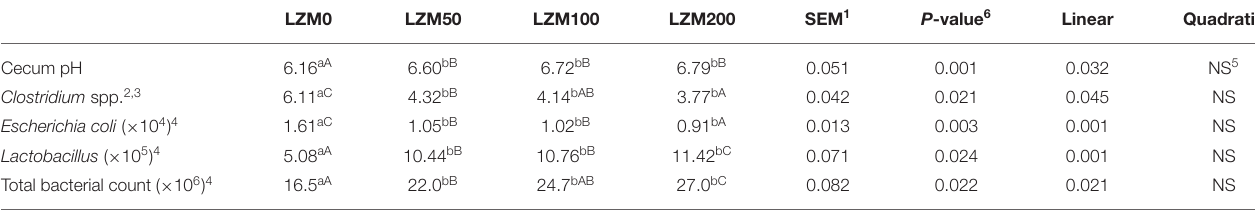
TABLE 3 | Effect of varying levels of chicken egg lysozyme (LZM) on cecum microbial activity of growing rabbits.